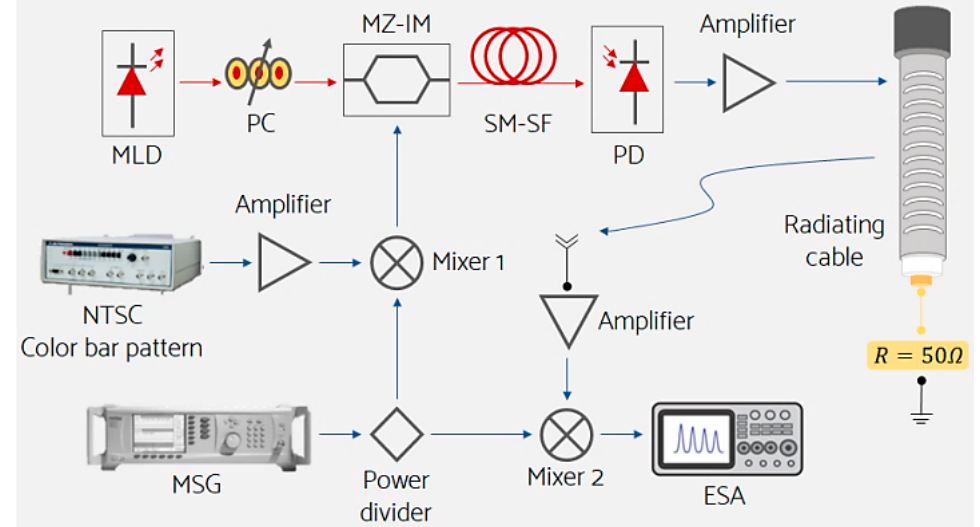
Figure 3. Experimental setup of the proposed fiber-radio scheme.